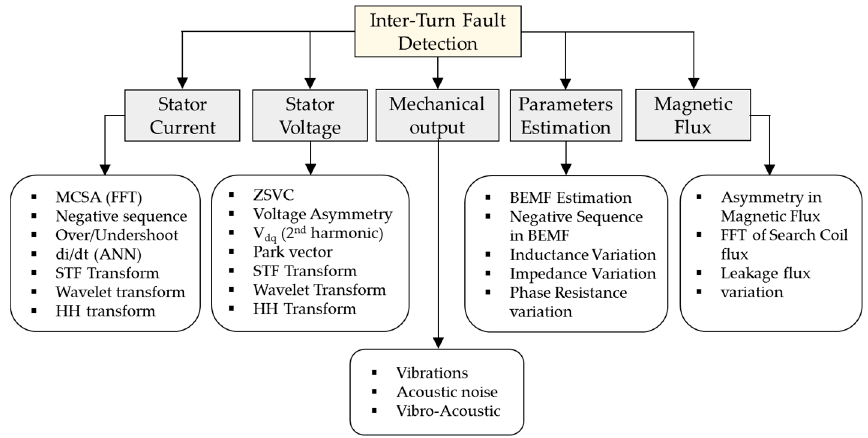
Figure 5. Summary of different fault index categories and their subcategories for ITSF.